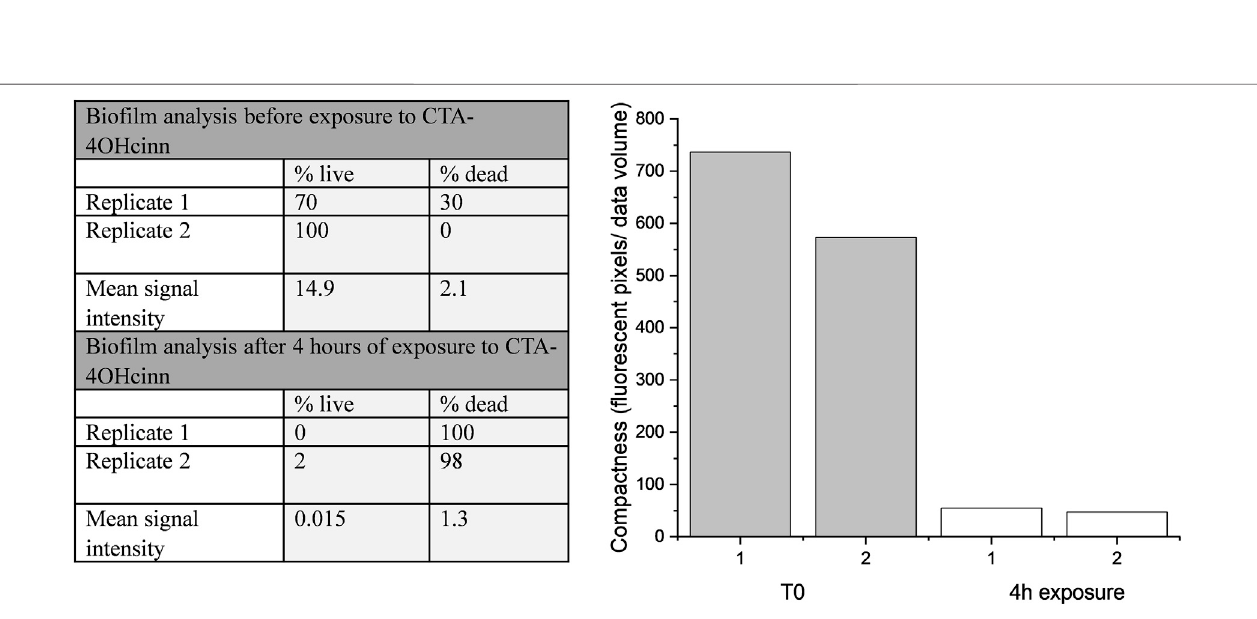
Frontiers in Bioengineering and Biotechnology |